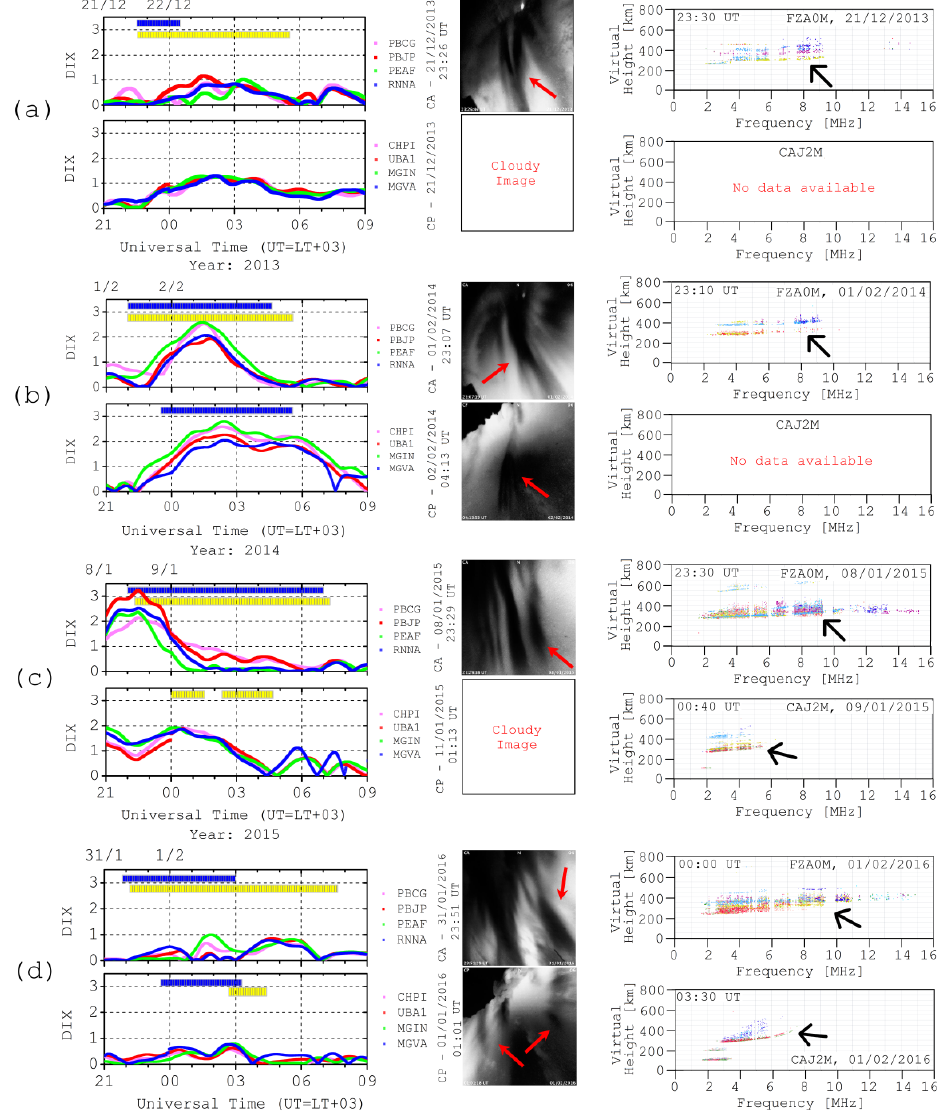
Figure 4. Time variations in the DIX (left panels) for equatorial and low-latitude stations, along with OI 630nm airglow images (middle pan- els) taken at CA and CP, and ionograms (right panels) showing the spread F occurrence at FZA0M and CAJ2M on 21–22 December 2013 (a)